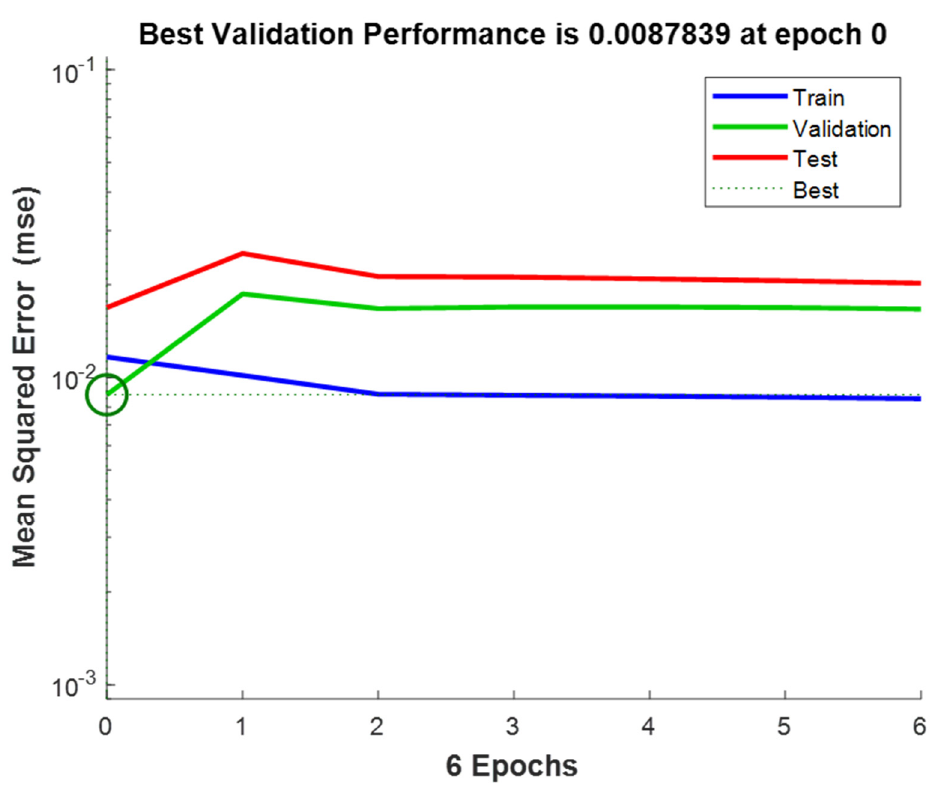
Figure 5. Mean square error for three plots.